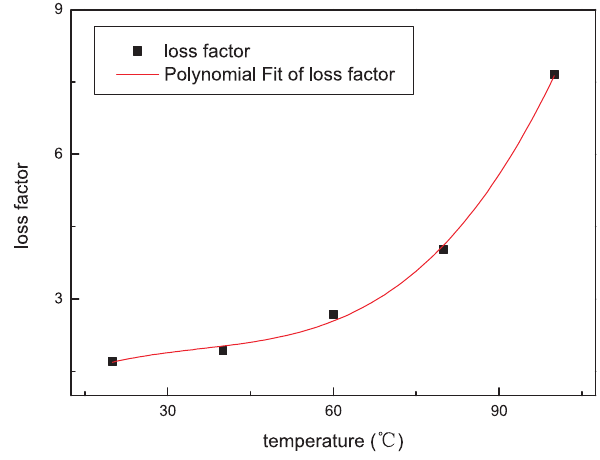
Fig. 8: Variation of loss factor of sodium chloride (4% moisture content) with temperature at 2.45